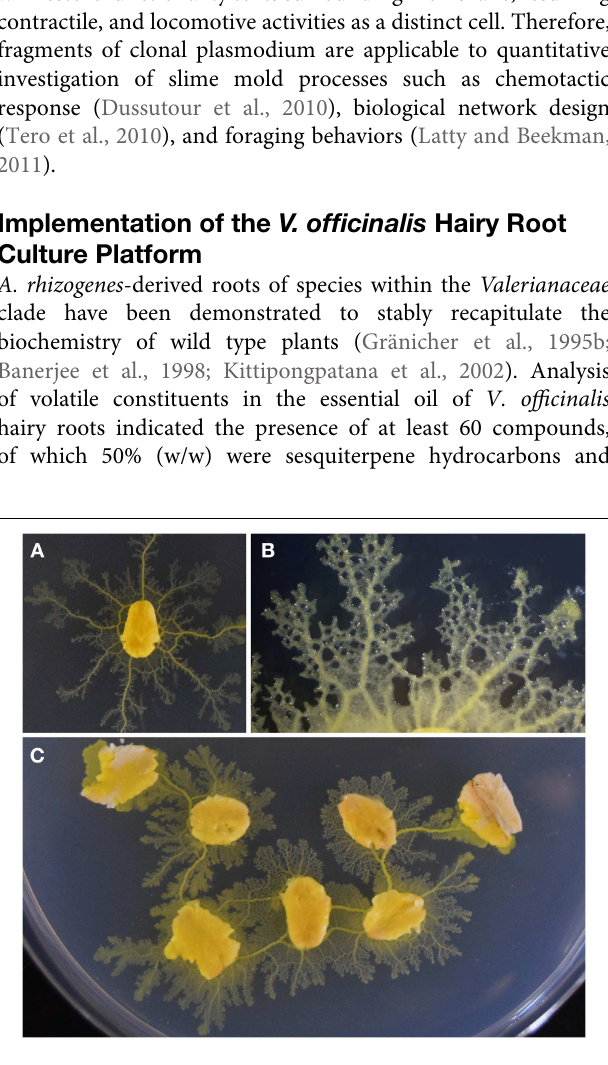
FIGURE 1 | P. polycephalum growth and networking behavior as viewed from above. (A) The organism extends concentrically from a colonized oat flake onto the agar substrate. (B) A growing tip of plasmodium and its network of protoplasmic tubes. (C) Foraging behavior of plasmodium showing the connection of multiple food sources. Thick tubes join the nodes of nutrients as the protoplasmic network develops.